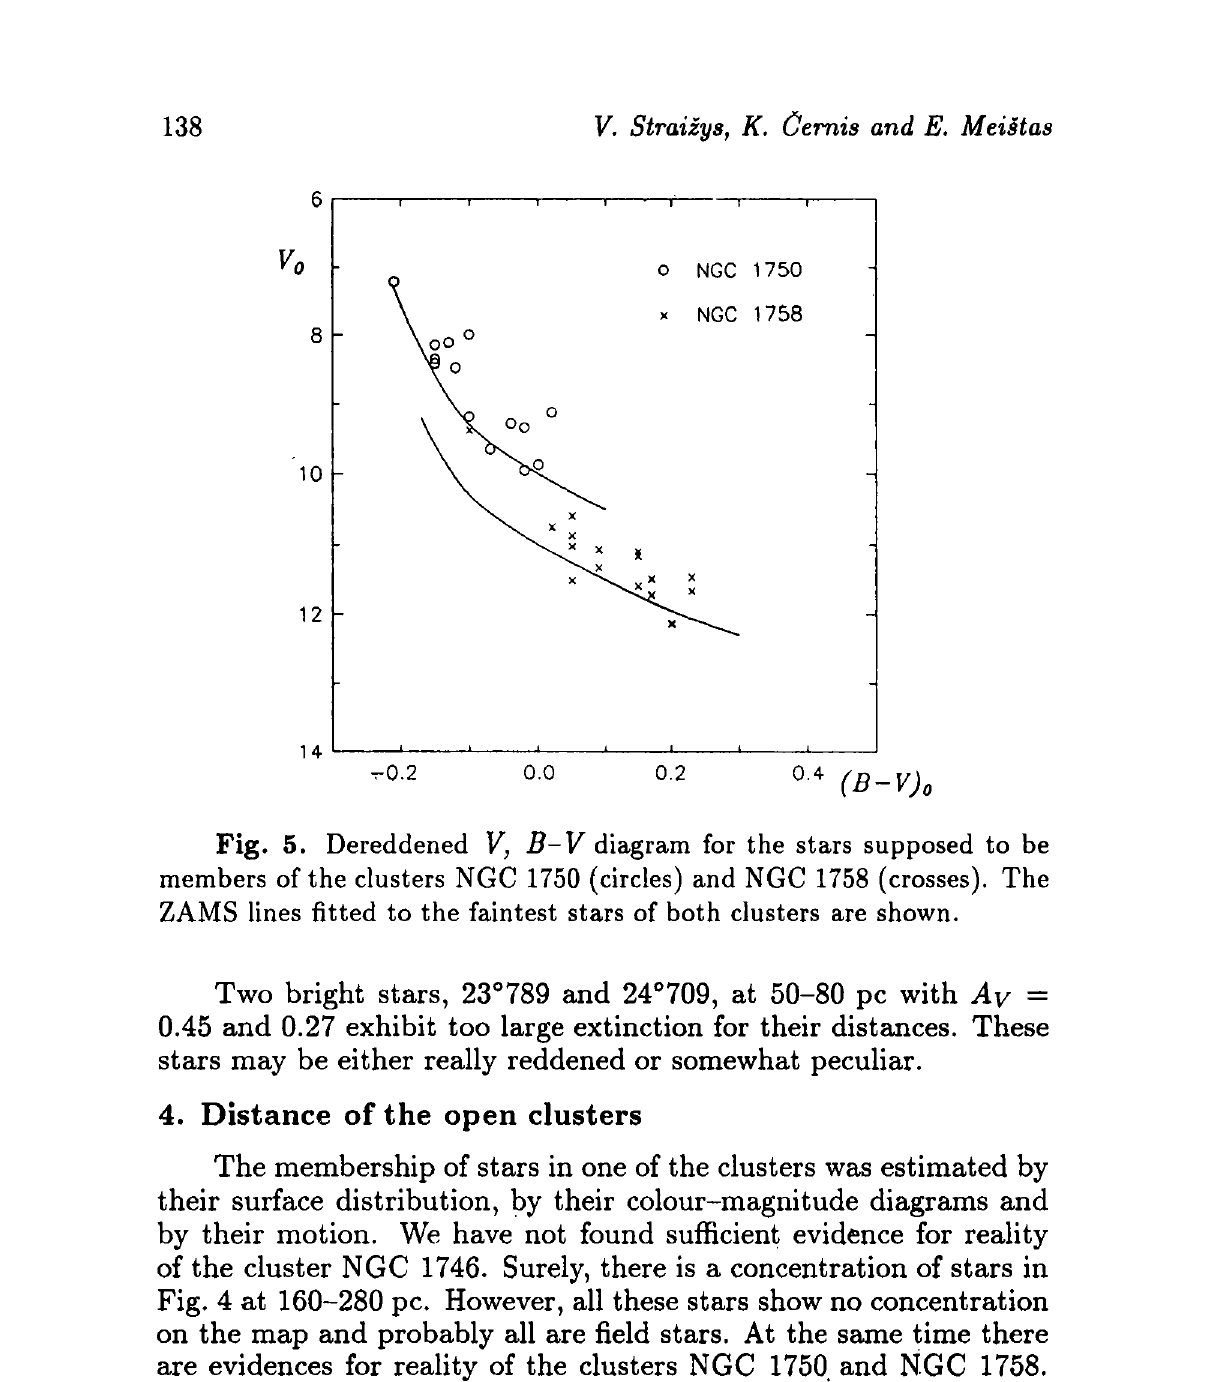
Fig. 5. Dereddened V, B-V diagram for the stars supposed to be members of the clusters NGC 1750 (circles) and NGC 1758 (crosses). The ZAMS lines fitted to the faintest stars of both clusters are